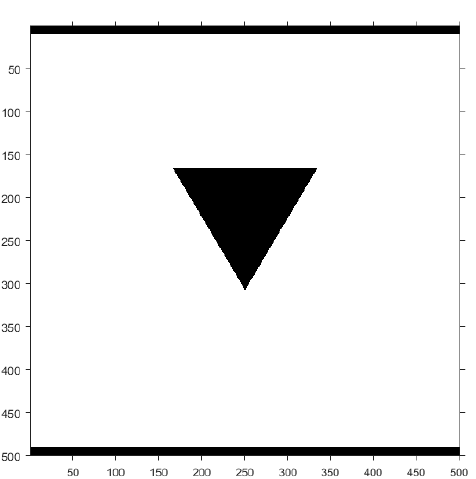
Figure A1. Simulation domain D2, which contains a triangular obstacle.